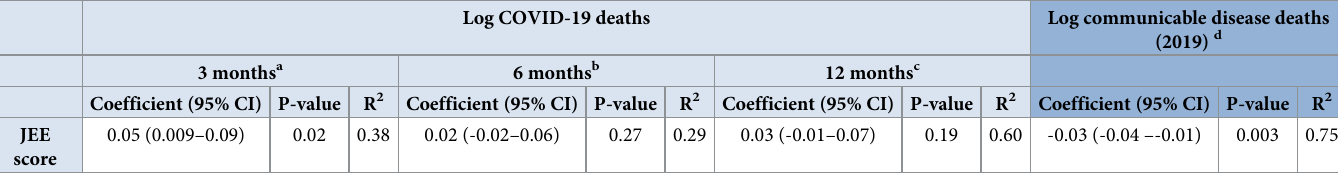
Table 2. Association between Joint External Evaluation scores and COVID-19 deaths per 100,000 population from multivariable linear regression models. Log COVID-19 deaths